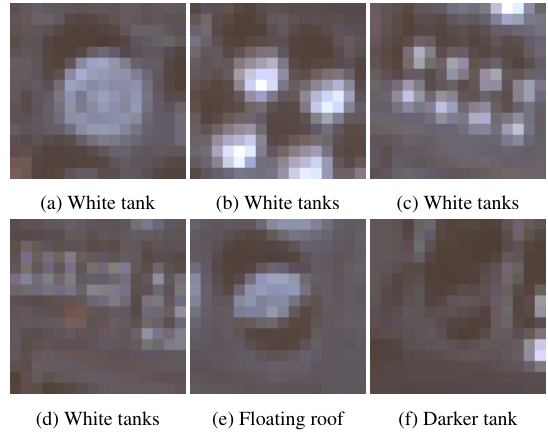
Figure 1. Examples of tanks in Sentinel-2